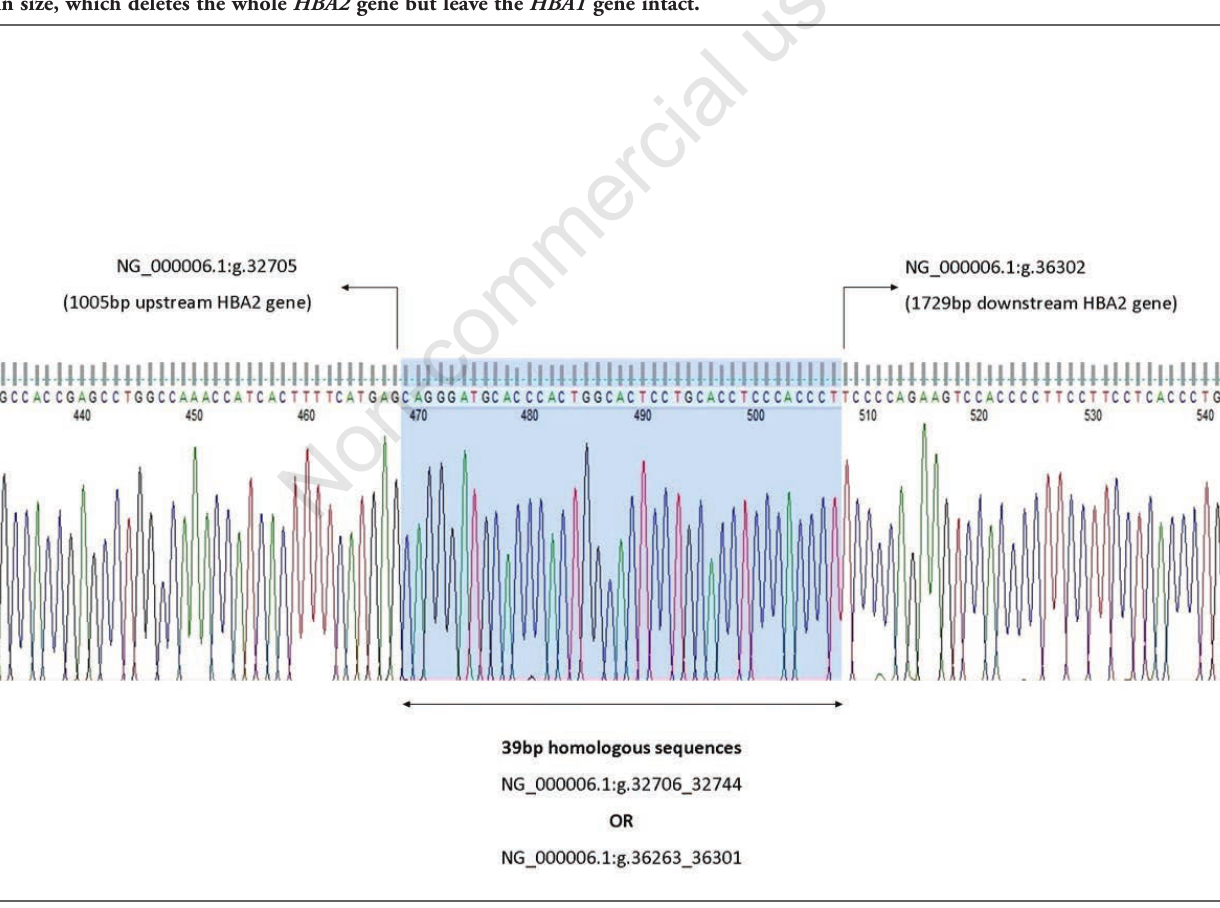
Figure 2. The 39 bp homologous sequences can be found at both 5’ and 3’ deletion breakpoint either at NG_000006.1:g.32706_32744 or NG_000006.1:g.36263_36301. Thus, the ( a MAL3.5 ) deletion can be mapped either from the 1004 bp upstream of HBA2 to 1689 bp downstream of HBA2 gene (NG_000006.1:g.32706_36262del3557) or from the 965 bp upstream of HBA2 gene to 1728 bp down- ‒ stream of HBA2 gene